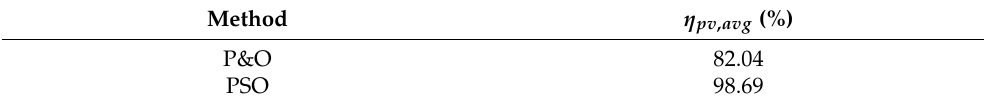
Table 2. Average efficiencies of the MPPT techniques (simulation).